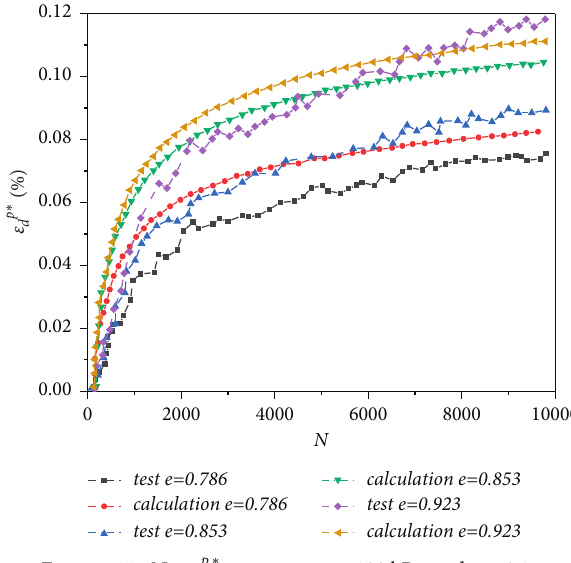
� 100kPa and η � 0.1. curve at σ 3 d